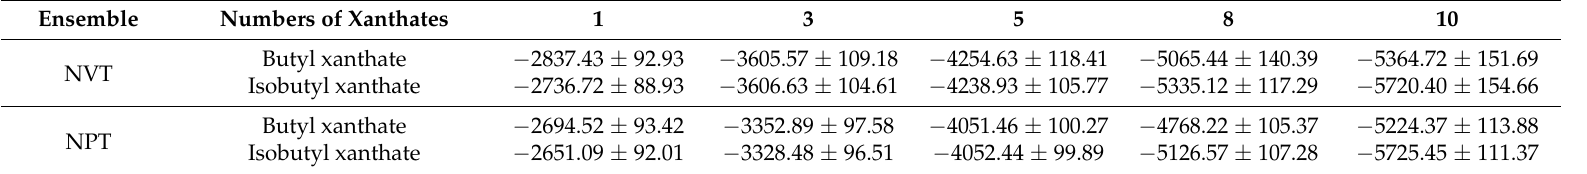
Table 3. Electrostatic energies of different xanthate concentrations in aqueous solution for NVT or NPT ensemble